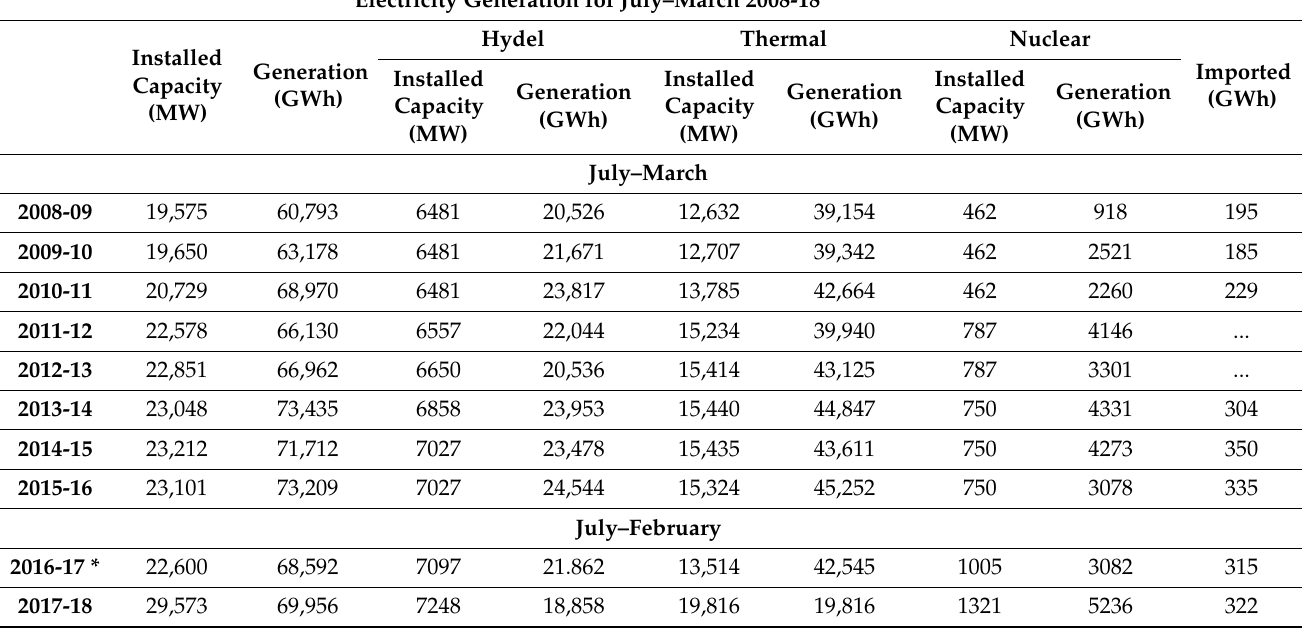
Table 2. Yearly Energy Generation of Pakistan 2008-18